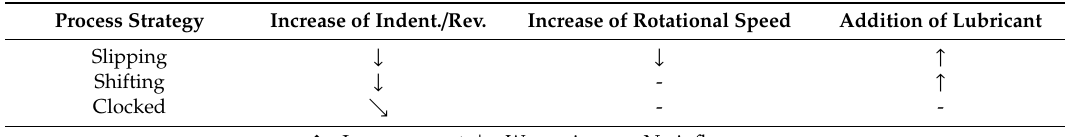
Table 3. Qualitative impact of the key process parameters on the surface quality. Process Strategy Increase of Indent. /